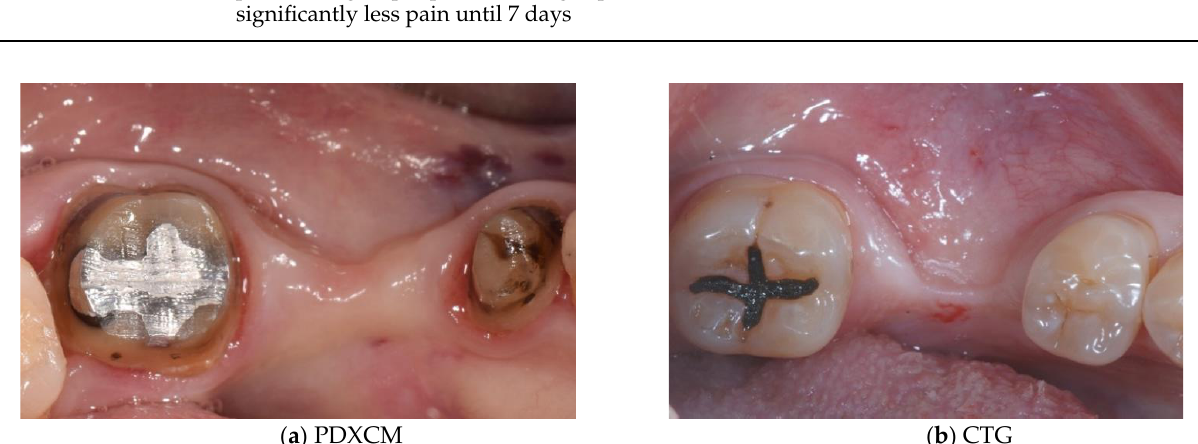
Figure 1. ( a , b ) Presurgical image of clinical case treated with PDXCM (right) and CTG (left).